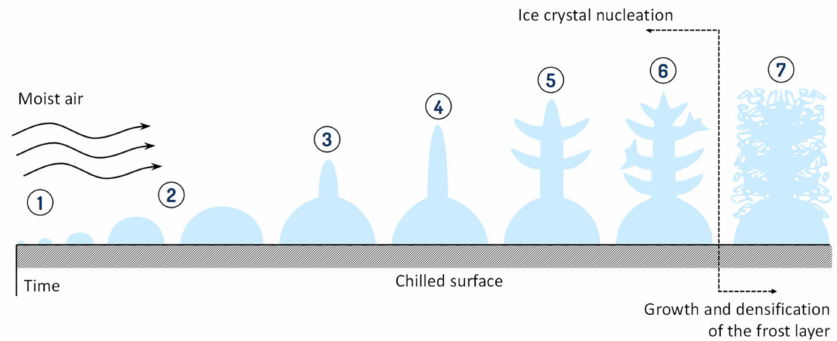
Figure 7. Schematic representation of the early crystal growth processes.